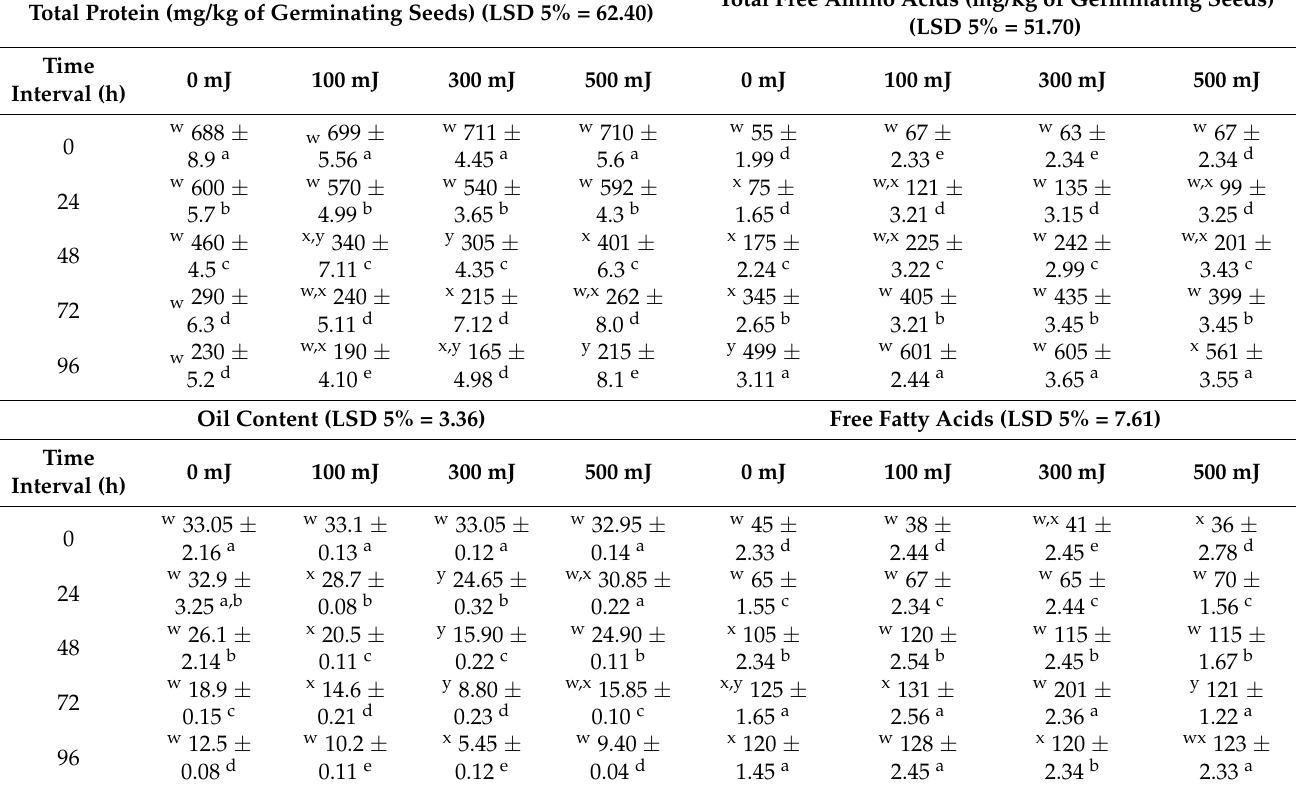
Table 3. Seed/seedlings total proteins, total free amino acid, seed oil and free fatty acid contents at different time intervals during germination when grown after irradiation with different doses of He–Ne laser (mean ± SE; n = 4). Total Free Amino Acids (mg/kg of Germinating Seeds) Total Protein (mg/kg of Germinating Seeds) (LSD 5% = 62.40) (LSD 5% = 51.70)